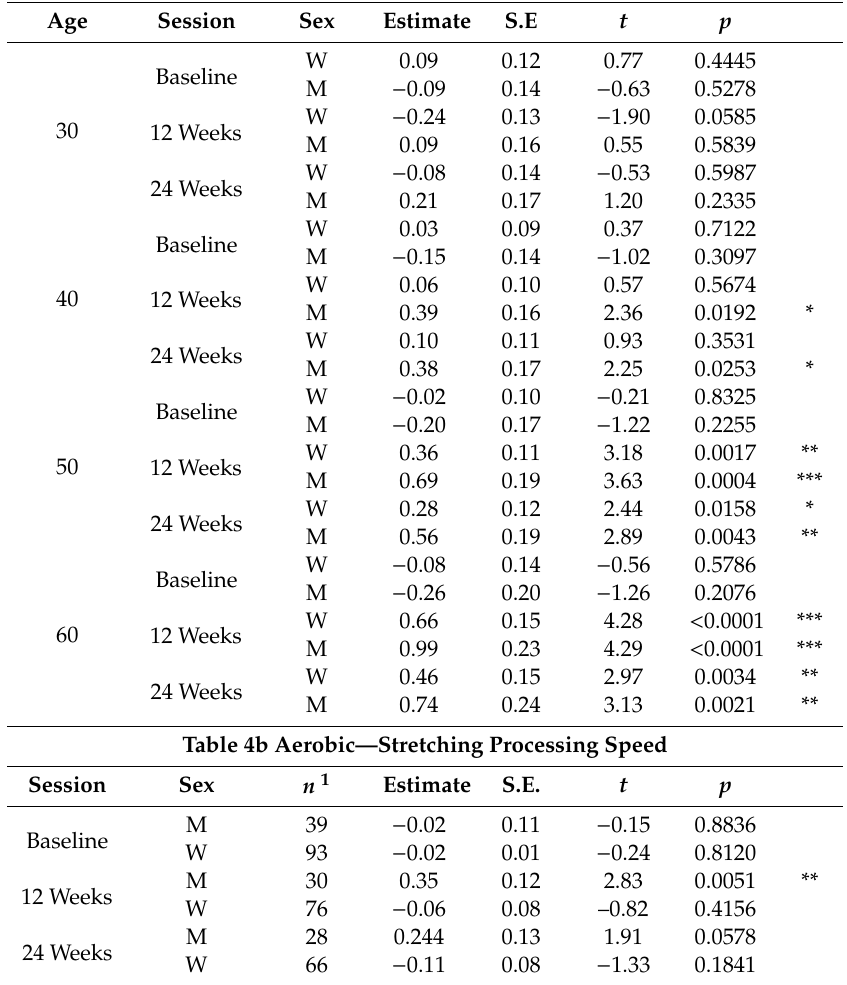
Table 4. Least square means di ff erences for performance of aerobic exercise vs. stretching toning groups on executive function (Table 4a) and processing speed (Table 4b), as illustrated in Figures 1 and 2. Numbers of subjects at each visit are listed in Table 2. Table 4a Aerobic—Stretching Executive Function